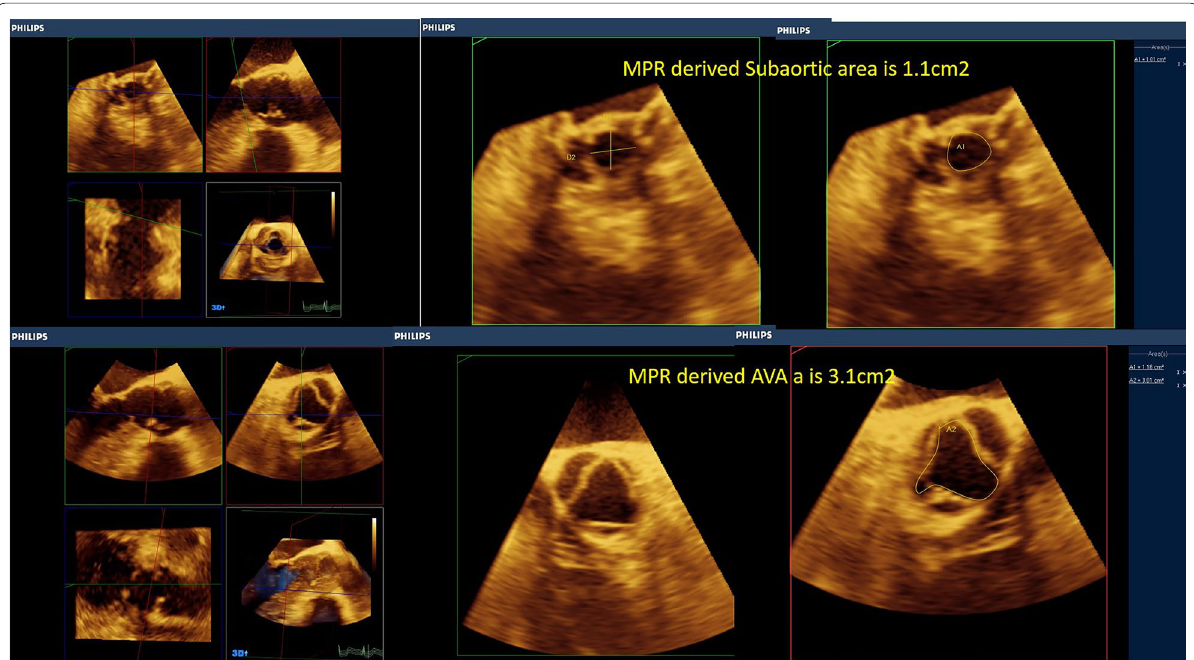
Fig. 12 Upper panels, multiplanar reformatting (MPR)‑derived diameters and area of the LVOT at the level of the subaortic membrane. (10 X 12 mm and 1.1 cm2, respectively) Lower panels, multiplanar reformatting (MPR)‑derived aortic valve area (mid‑systolic and at the tips) is 3.1